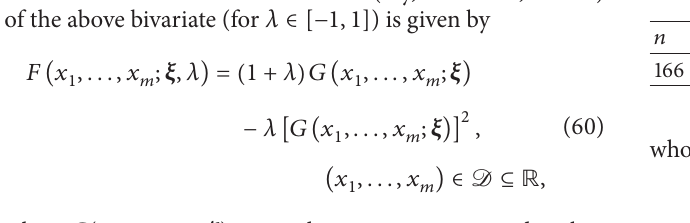
Table 3: Descriptive statistics for the data